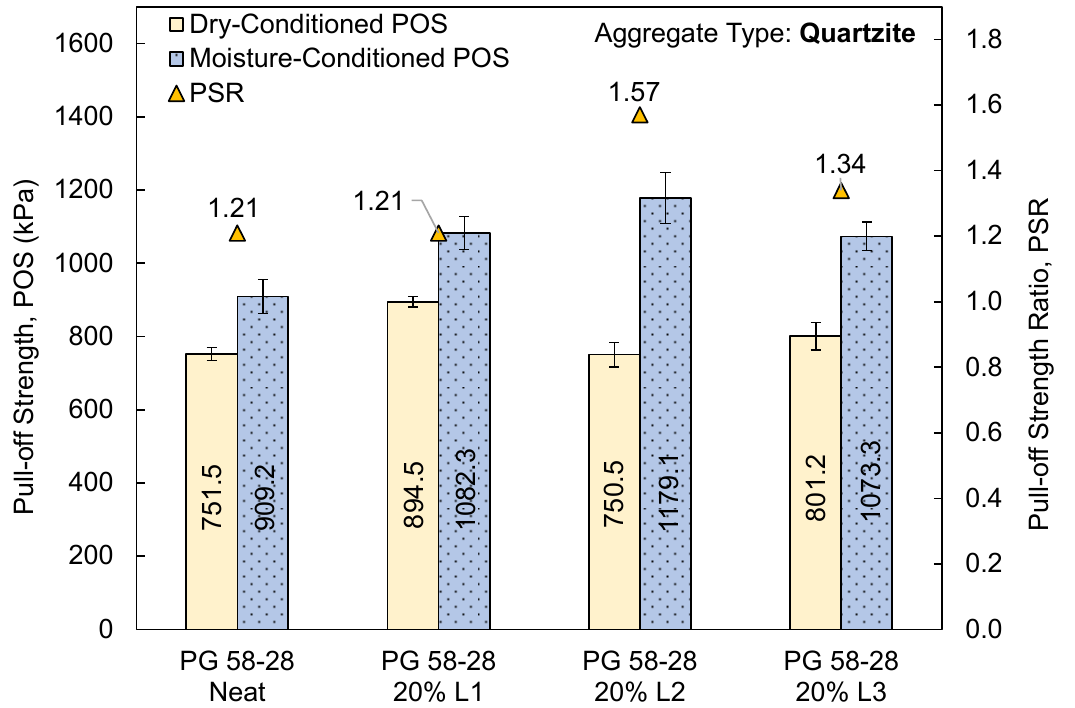
Figure 11. Average POS Dry , POS Wet , and PSR Values of Binder Blends with Quartzite Aggregate.